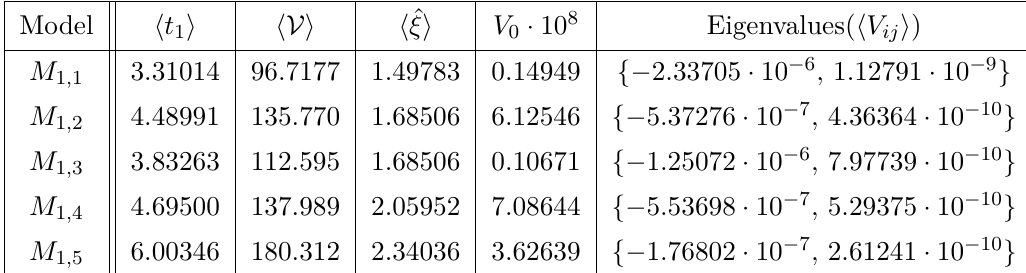
= − 1 , g = 0 . 35 , a = π , 0 s 1 16